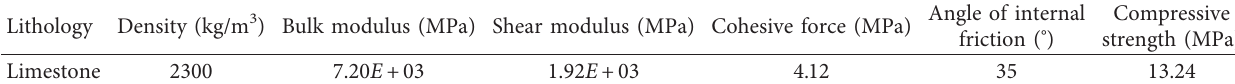
Table 2: Rock physical mechanical parameters.